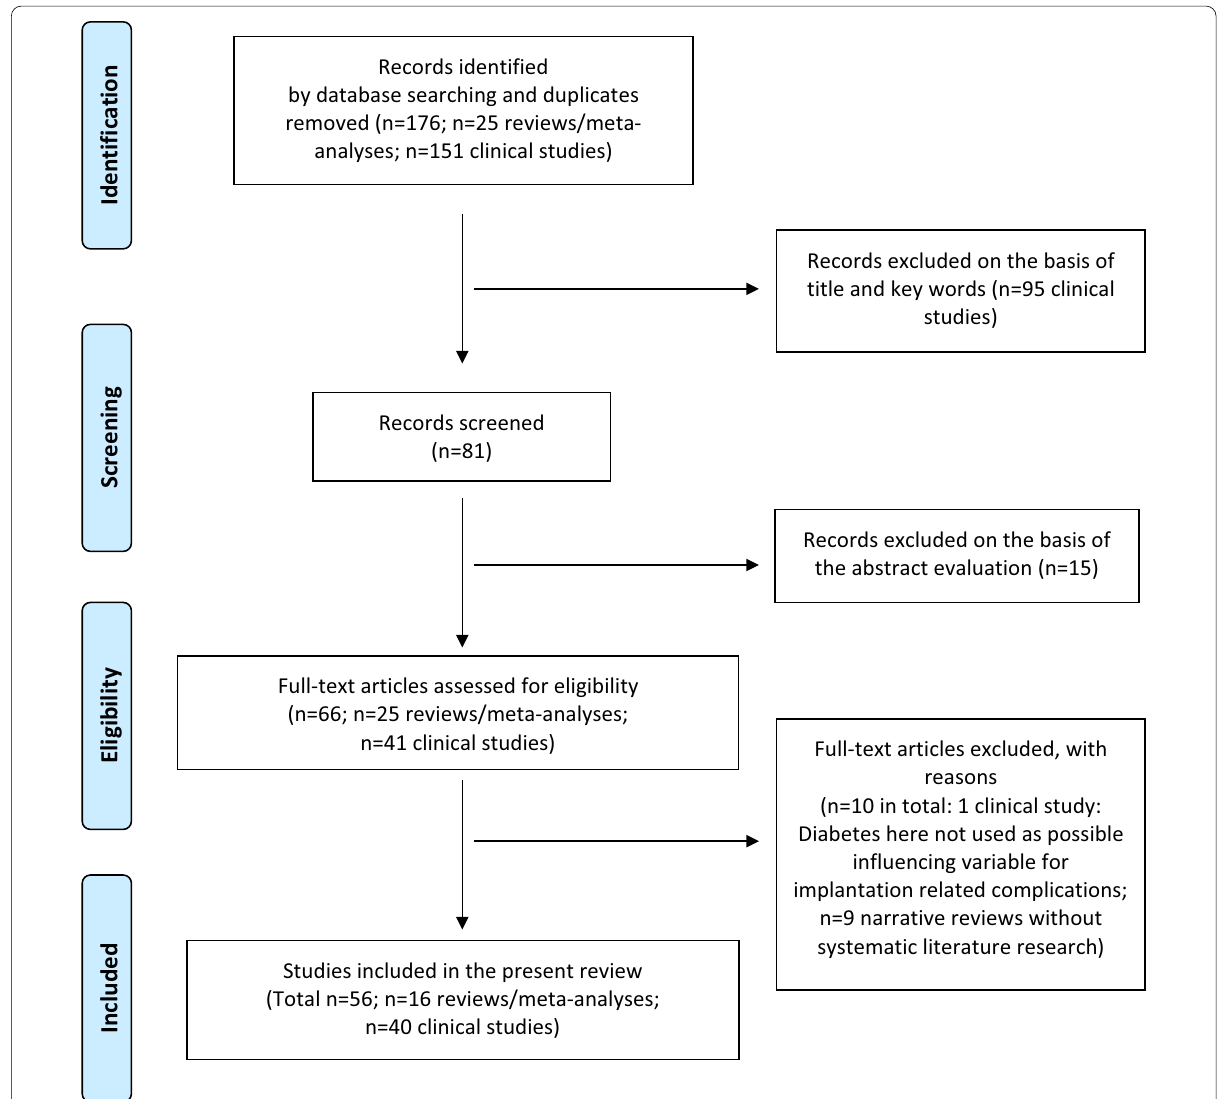
Fig. 1 Flowchart of identified, excluded and included